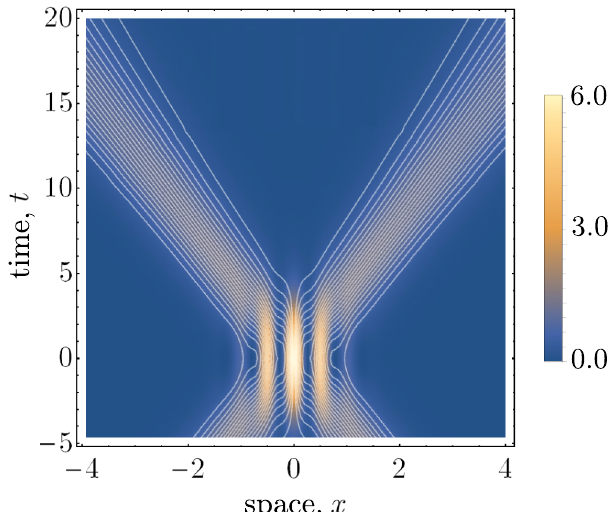
Fig. 4 Bohmian trajectories for a generic relativistic dispersion with k σ = 6, k z / σ = 24, and α = 1/2. The effect of k z is to introduce some 0 / dispersion in the trajectory density as the particles propagate in time.